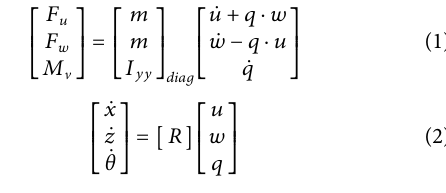
coated fi lm indicating the approximately 1.5 μ m thick shellac coating and suf fi cient surface bonding. SEM images of the CNF: Supplementary Figure S3. The fi gure summarizes the fi lm ’ s top-view before and after coating as well as the